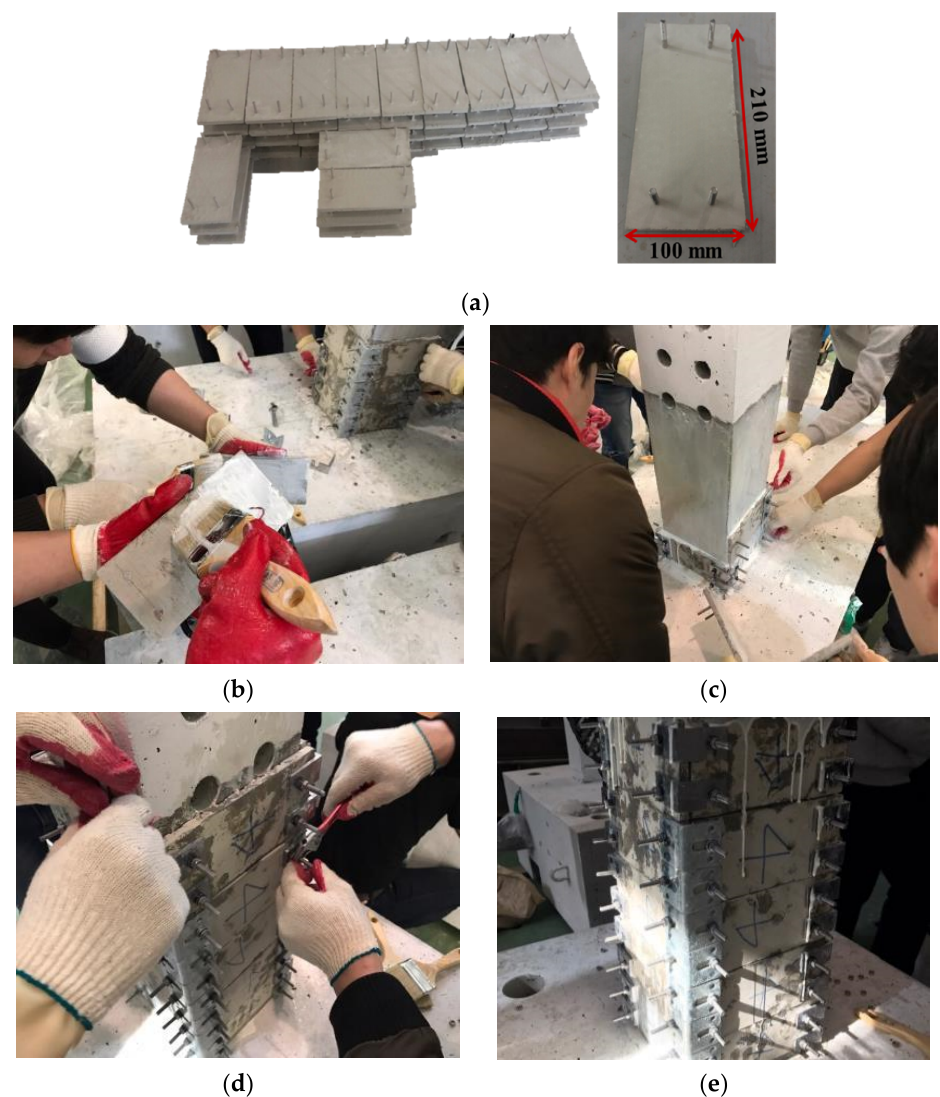
Figure 5. Retrofitting process of the specimen with 3D-TRM panel: ( a ) 3D-TRM panels; ( b ) Epoxy coat- ing on the surface of 3D-TRM panel and RC column; ( c ) Attachment of 3D-TRM panel; ( d ) Installation of shear keys; ( e ) Curing